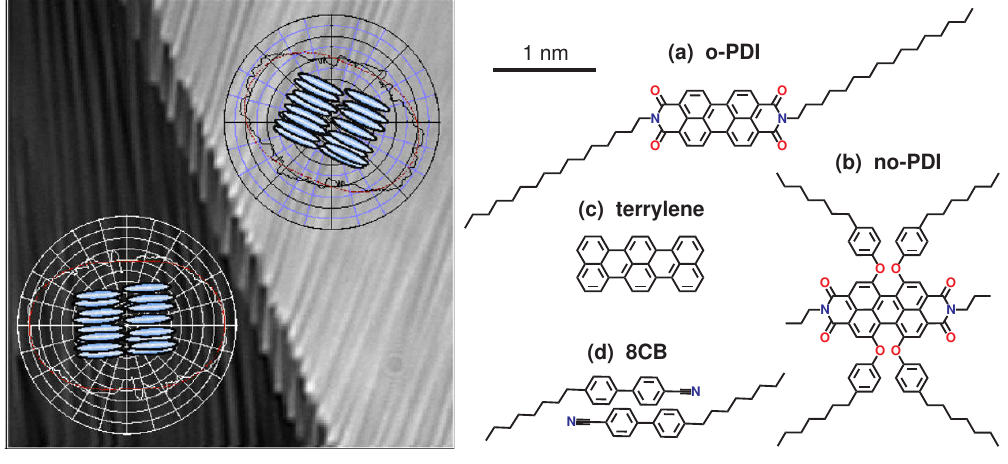
Figure 1. ( Left ) 8CB cell with two regions of ordering (bottom left) area 1, and (top right) area 2. Schematics of LC orientation are given together with the angular diffusion maps and their fits using a model for anisotropic diffusion (red lines) for each region. Reprinted with permission from [34], Copyright 2012 by The American Chemical Society. ( Right ) Molecular structure of ( a ) aligning perylene diimide o-PDI; ( b ) not aligning perylene diimide no-PDI; ( c ) terrylene; and ( d ) columnar LC unit of